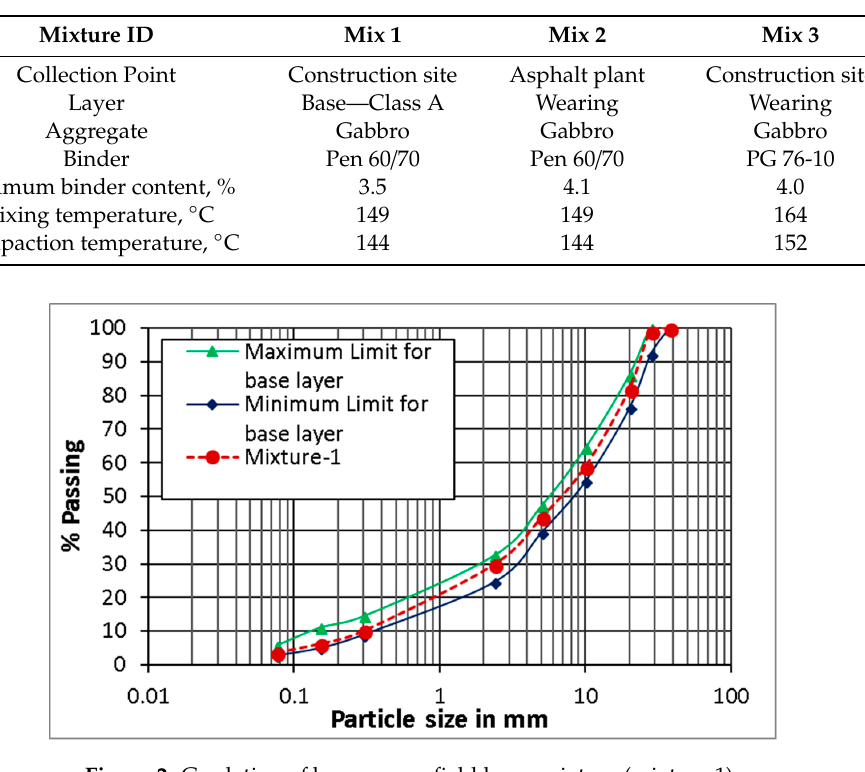
Figure 2. Gradation of base course field loose mixture (mixture 1).